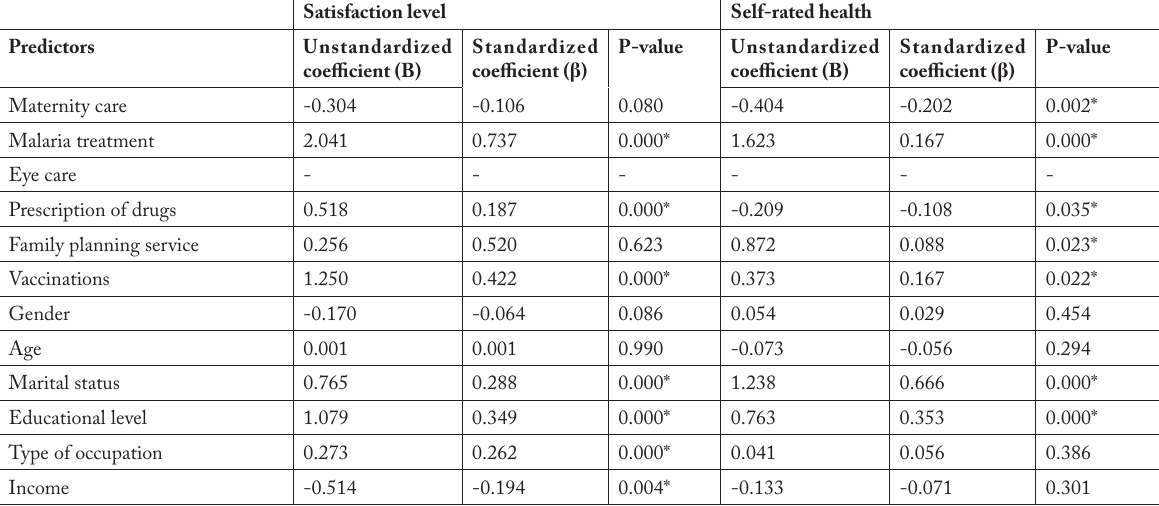
Table 2. Predictors of patient satisfaction and self-rated health by multiple regression analysis ( n = 337).